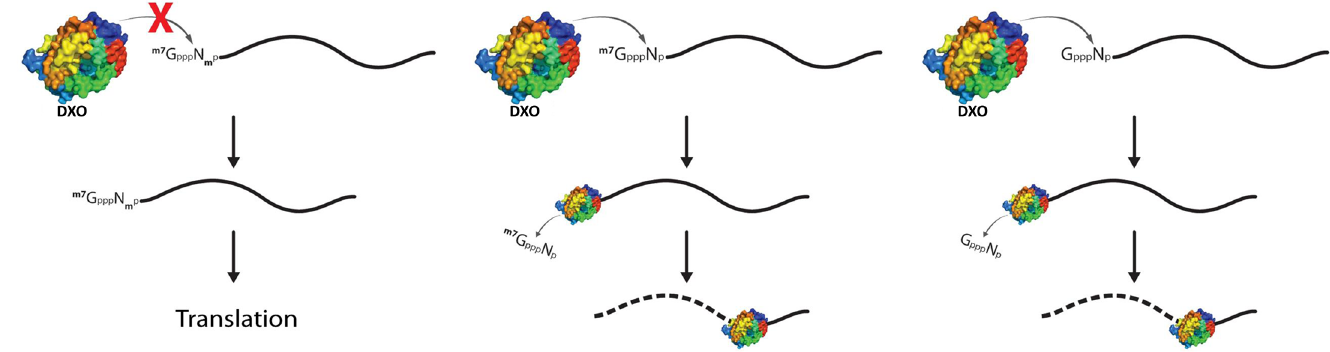
S1 Fig. Decapping assay with DXO mutants. Three mutant DXO proteins were generated and tested in a decapping assay using GpppG-RNA as substrate. Wild-type DXO as well as the R145A-Q146A-E147A and R177A-M185A mutants readily cleave this cap structure.